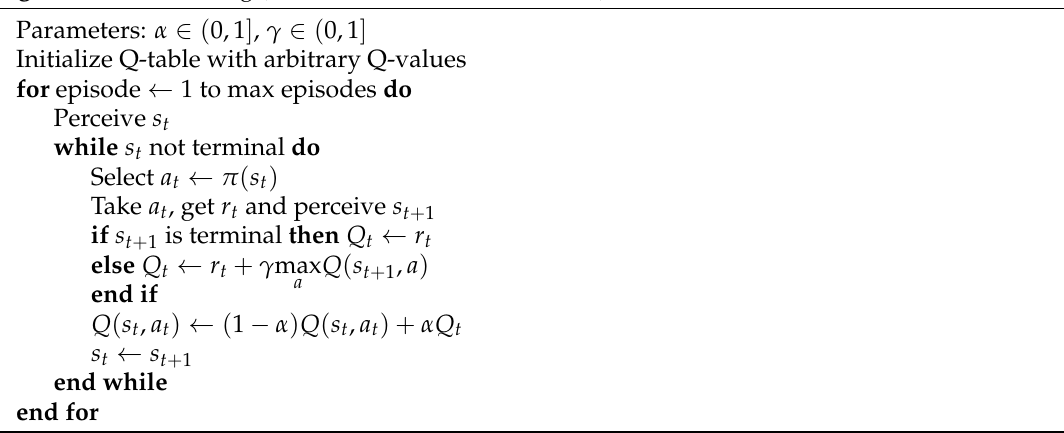
Algorithm 1 Q-learning (for deterministic